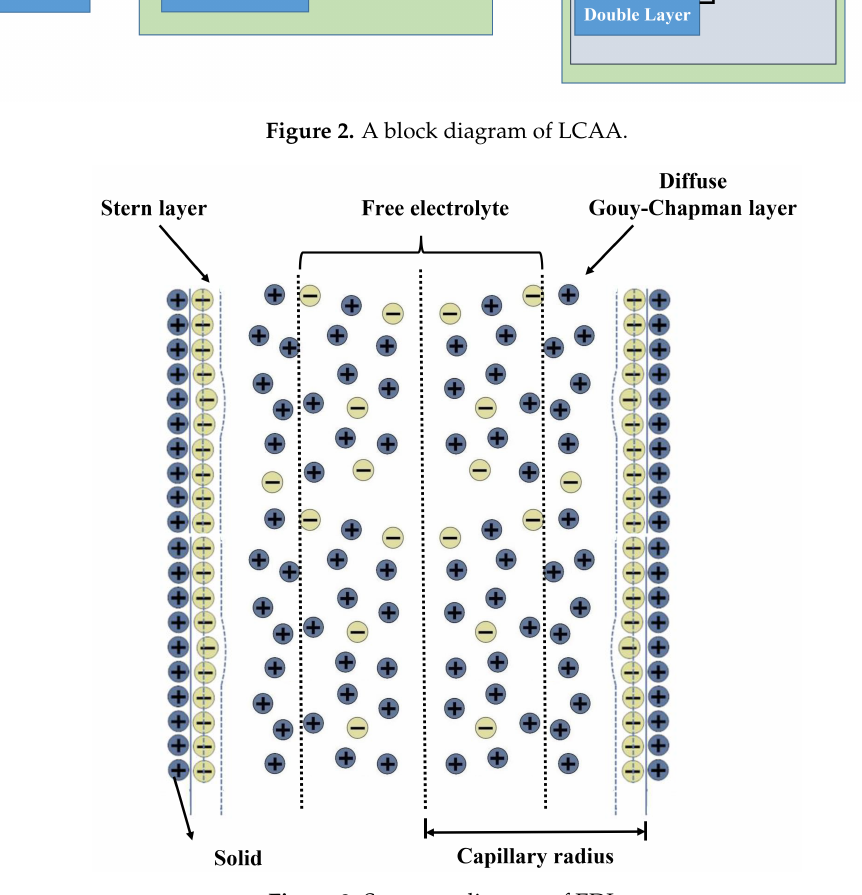
Figure 3. Structure diagram of